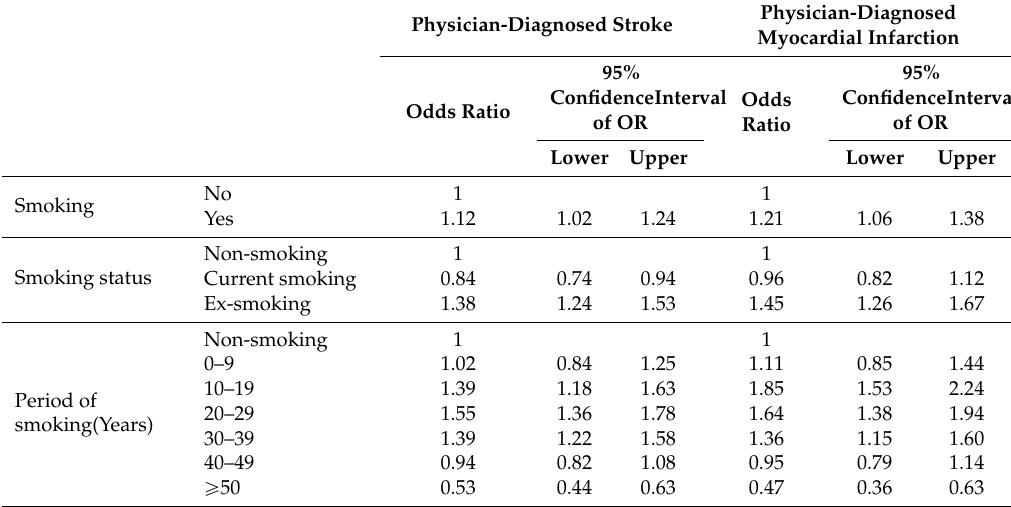
Table 3. Association between smoking and physician-diagnosed stroke and myocardial